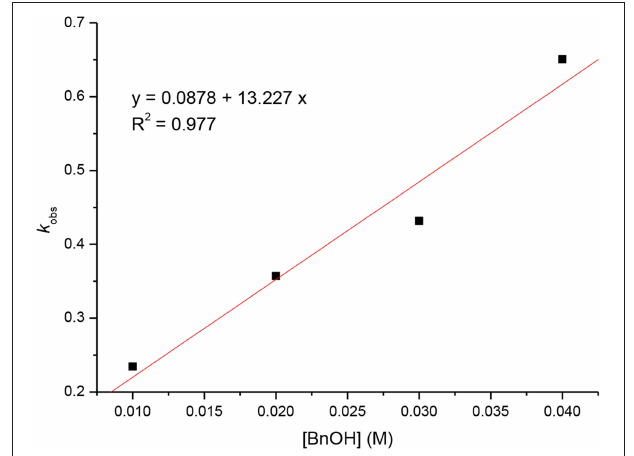
FIGURE 8 | Linear plot of k obs vs. [BnOH] for the polymerization of L -LA with [ L -LA] = 0.5M in toluene (10mL) at 25 ◦ C.